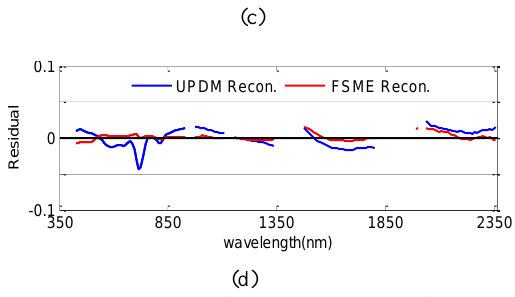
Figure 2. Comparison of the residual errors of UPDM (blue) and FSME (red): (a) water vegetation (d) mixture